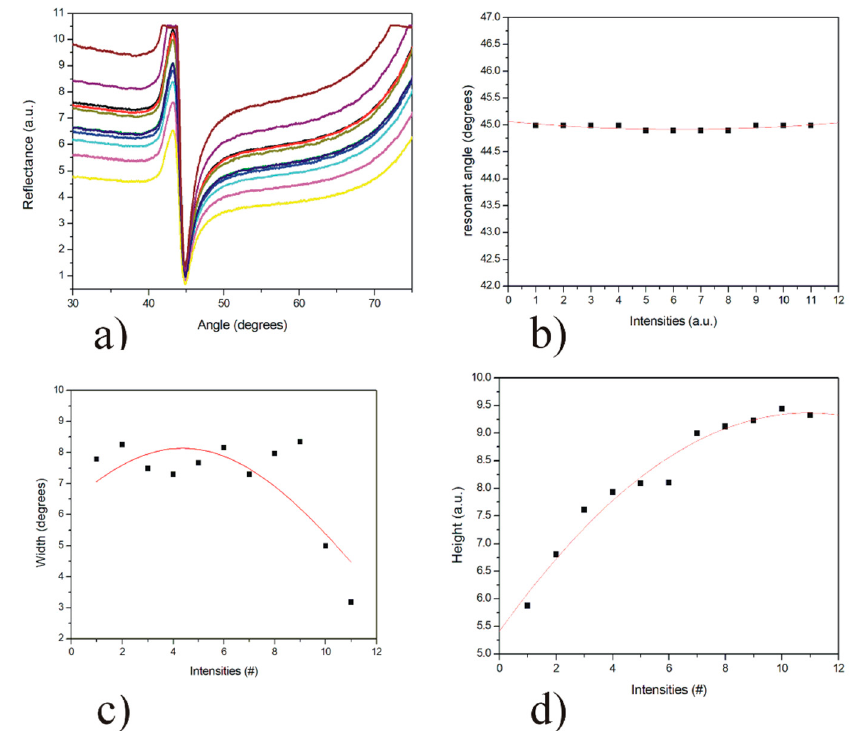
Figure 2. Analysis of the influence of the intensity of the illumination source. ( a ) Experimental SPR curves of a substrate with a Cr/Au thin film, ( b ) resonant angle for the SPR curves at different intensities, ( c ) graph of the width of the SPR curves, ( d ) graph of the height of the SPR curves.